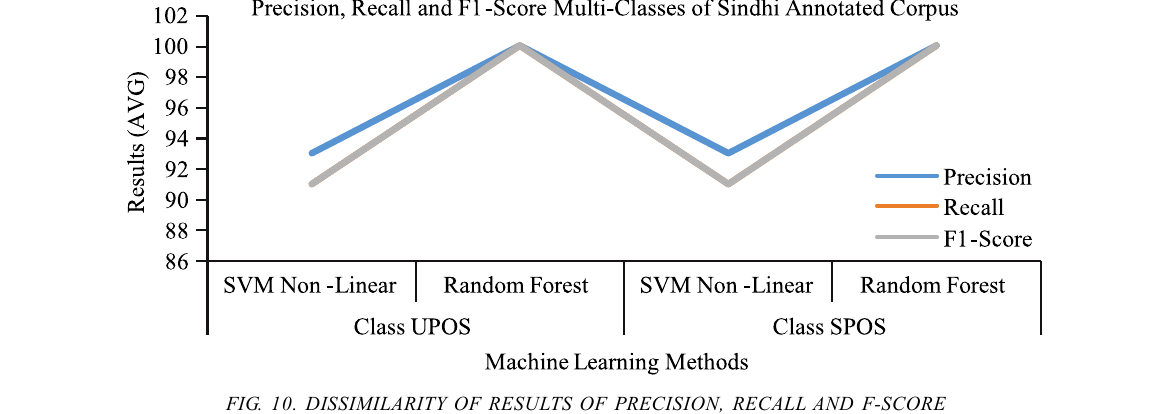
FIG. 10. DISSIMILARITY OF RESULTS OF PRECISION, RECALL AND F-SCORE